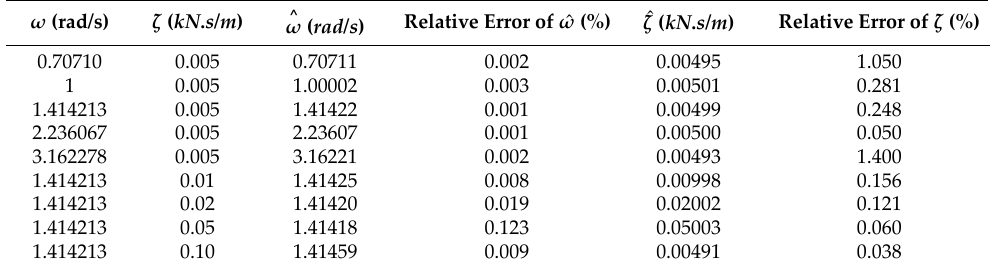
Table 1. Estimation of the PINN for dynamic